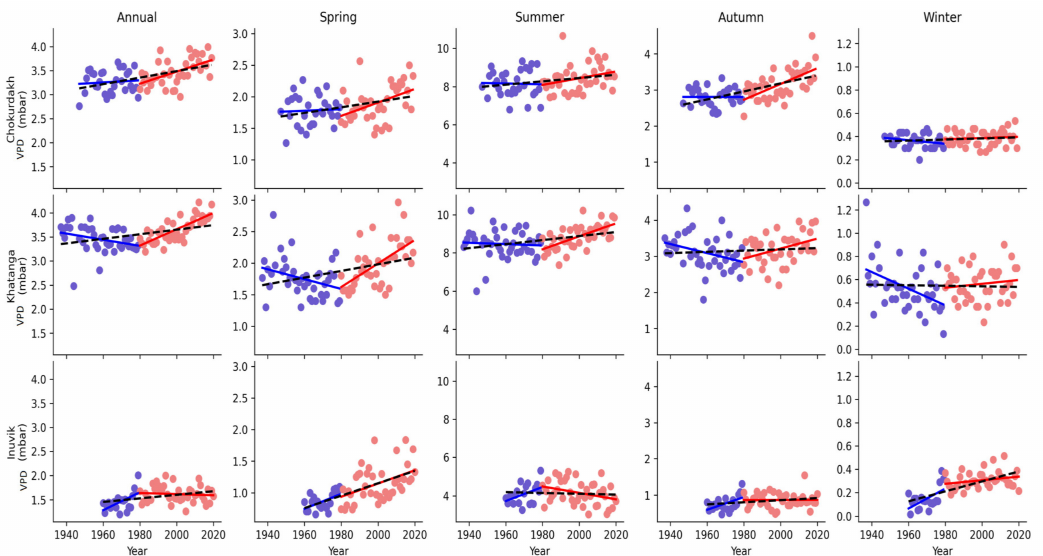
Figure 5. Annual, spring, summer, autumn and winter vapor presseure deficit (VPD) data were obtained from the local meteo.ru database for Chokurdakh (YAK) and Khatanga (TAY), while they were obtained from climate.weather.gc.ca (Accessed on 30 August 2021) for Inuvik (CAN),